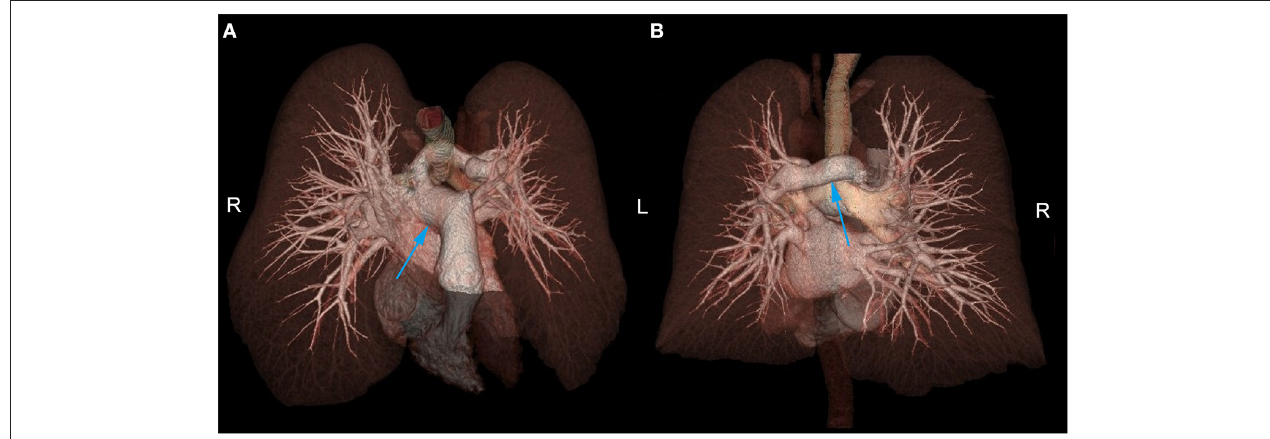
FIGURE 3 | Anatomical structure of the artery, bronchus and vein of the left lower lobe. LSSA, Left superior segmental artery; LCBA, Left common basal artery; LLLB, Left lower lobe bronchus; LIPV, Left inferior pulmonary vein.